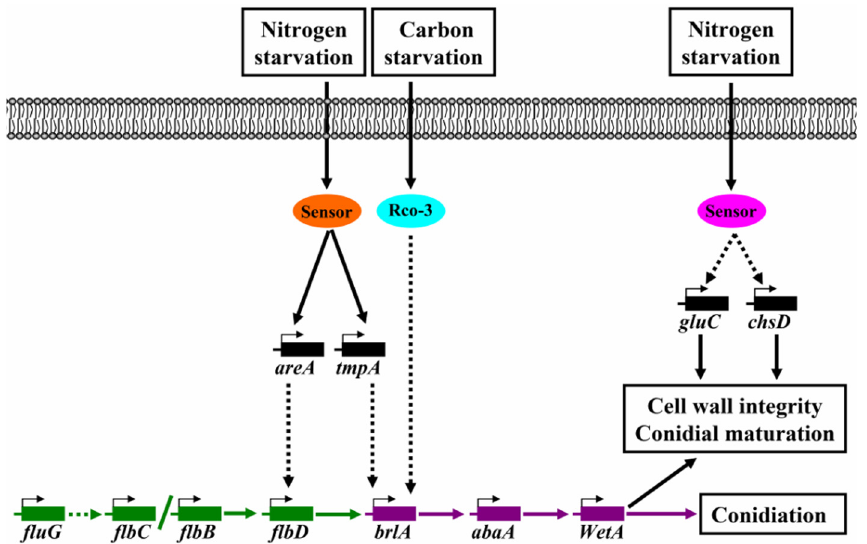
Figure 5. Proposed nutrient limitation induced signaling pathway of conidiation for A . cinnamomea .